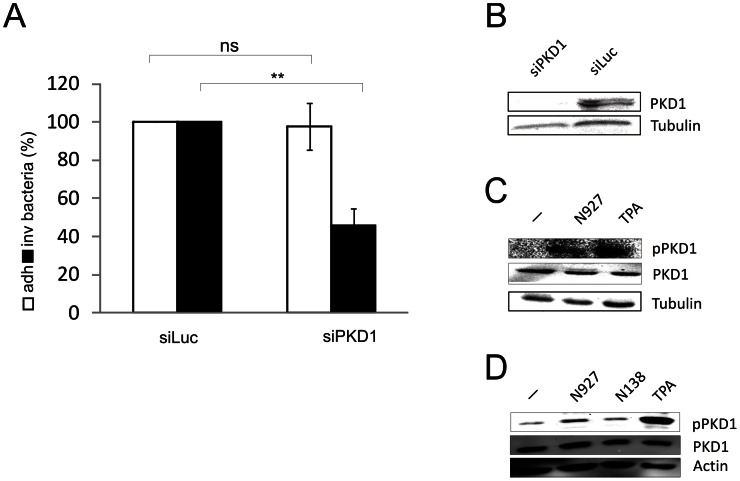
PKD1 is required for invasion of N927.(A) Chang cells were transfected with siRNAs against PKD1 (siPKD1) and luciferase (siLuc) as control. The cells were infected with N927 (PorBIA, P−; MOI 10) for 30 min 72 h after transfection of siRNAs. Intracellular (inv., black bars) and adherent (adh., white bars) bacteria were quantified by gentamicin protection assay and the number of adherent or invasive bacteria of control cells (siLuc) was set to 100%. Shown are the means ± SD of three independent experiments performed in duplicates. p<0.01: ** (B) Knock down of PKD1 in Chang cells was verified by Western blotting. β-tubulin was used as loading control. (C) Endogenous levels of phosphorylated PKD1 (pPKD1) were assayed after infection with N927 (MOI 100) or treatment with the known activator 12-O-Tetradecanoylphorbol 13-acetate (TPA, 0.2 µM) for 30 min. Whole cell lysates were analyzed by immunoblotting using phospho-specific PKD1 antibody (detects pSer744 and pSer748). (D) PKD1 was overexpressed by transfection of PKD-HA expression construct (Addgene; [41]) in Chang cells and phosphorylation was detected as described in (C).